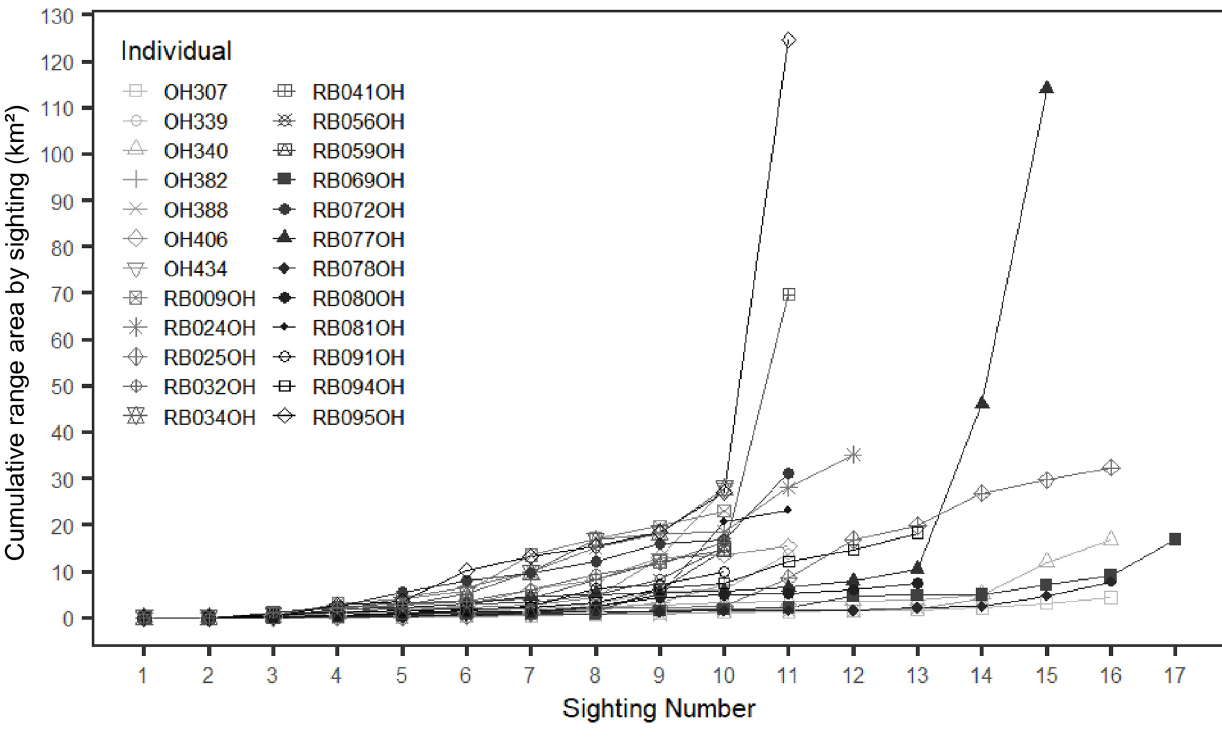
FIGURE 2 | Cumulative range area (MCP in km 2 ) for each individual (with at least 10 sightings) as a function of the number of times